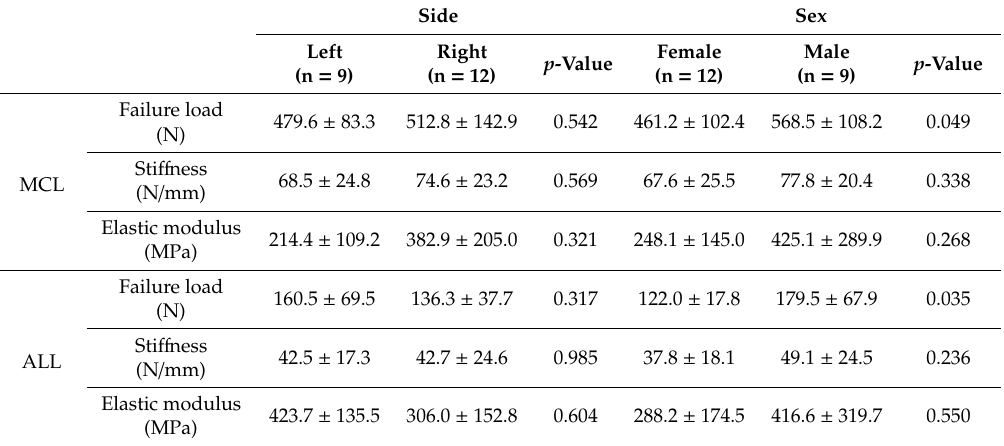
Table 5. Side and sex di ff erences among the